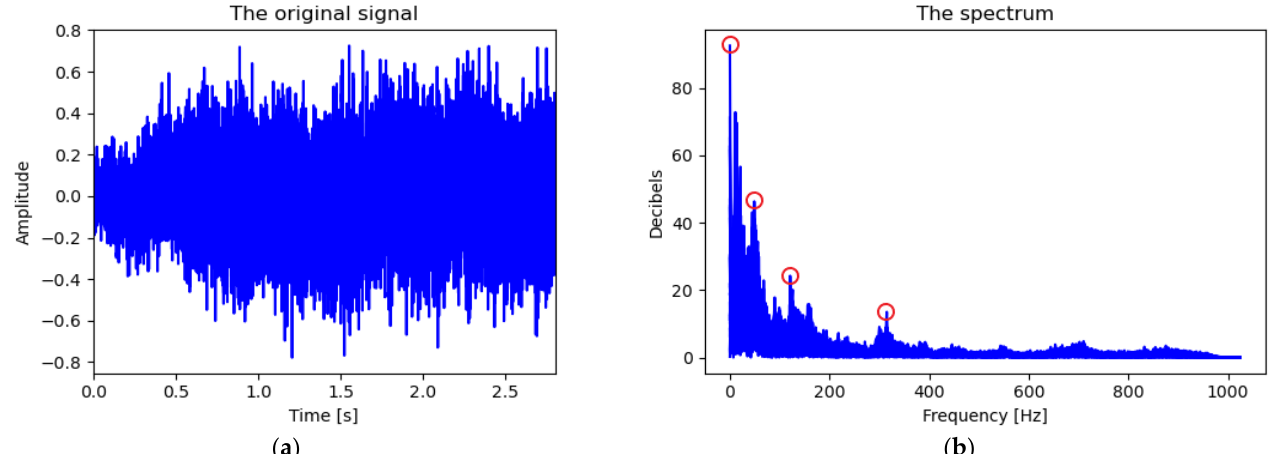
Figure 2. A sample of recorded HVAC sound ( a ) and its conversion into spectrum with the help of Fourier transform with pointed peaks ( b ).